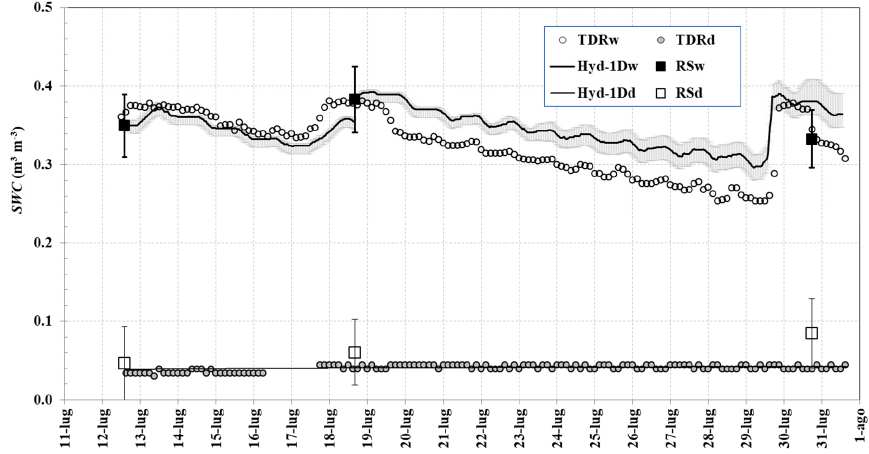
Figure 6. Apparent thermal inertia (ATI)* spatial distribution (left panel) and pseudo color composition of SWC R S (right panel); shadowed pixels are in white highlighted masked.